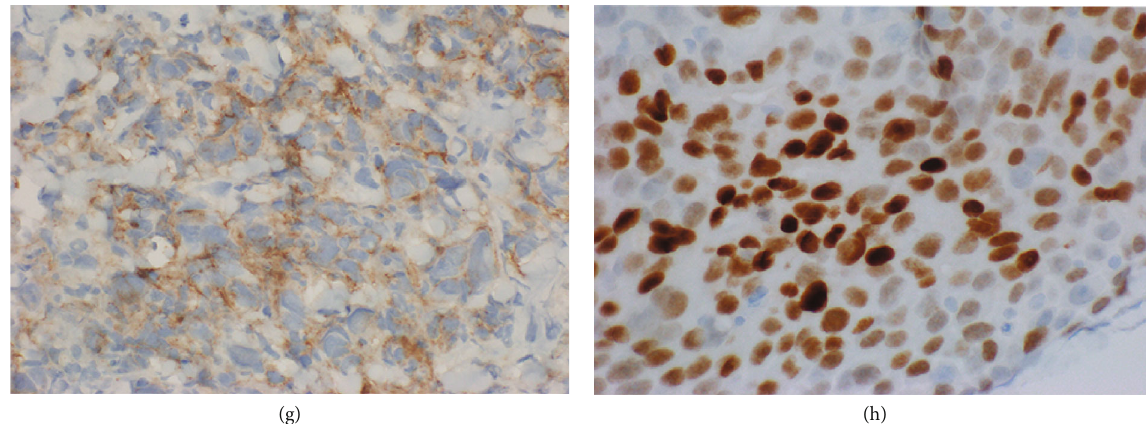
Figure 2: Histologic and immunohistochemical features of plasmacytoid colorectal carcinoma (CRC): plasmacytoid CRC di ff usely invades bladder wall with benign overlying urothelium (10x, 40x) (a, c); plasmacytoid CRC invades colonic mucosa, and rare signet ring cells are present (10x, 40x) (b, d); plasmacytoid CRC with immunoreactivity for SATB2 (e); CK20 (f); CD138 (g); CDX2